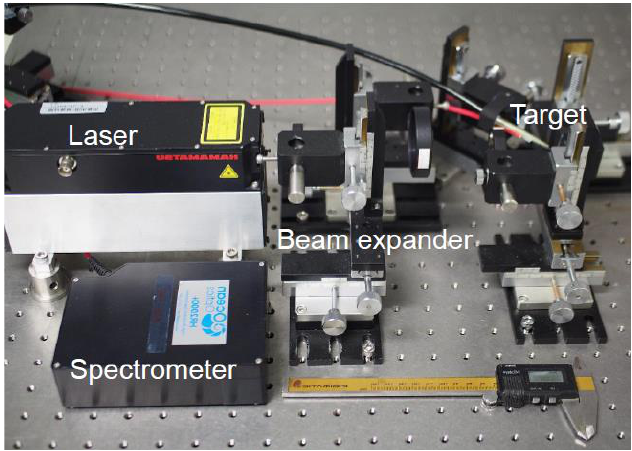
Figure 1. Measurement setup.